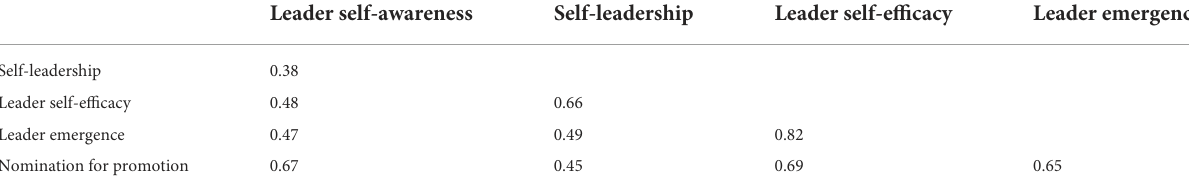
TABLE 4 Upper confidence intervals of correlations between factors to test for discriminant